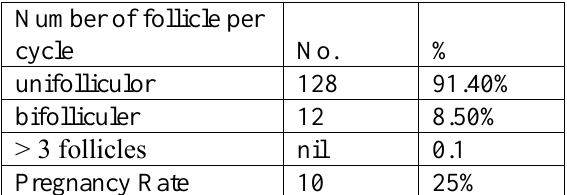
Table-6: number of ovarian follicles observed in